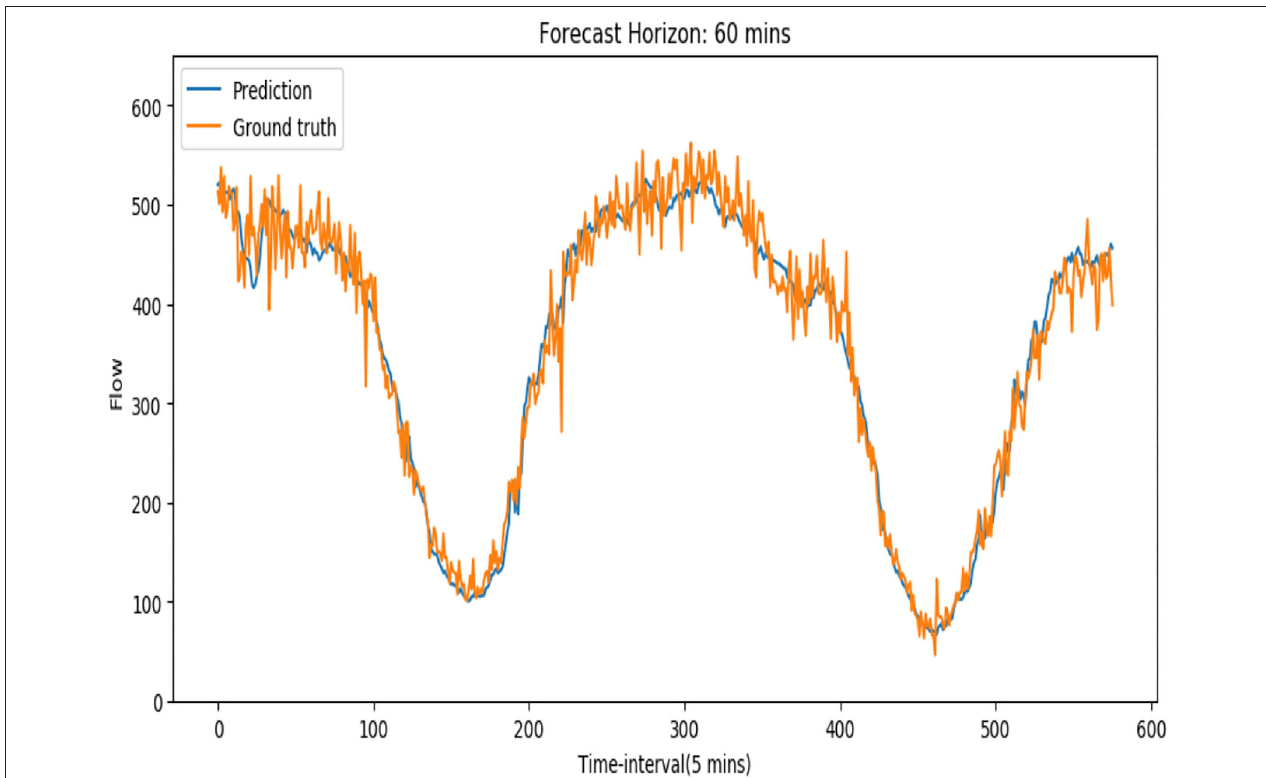
FIGURE 7 | Traffic flow prediction and the corresponding ground truth of a sensor during 2 days.